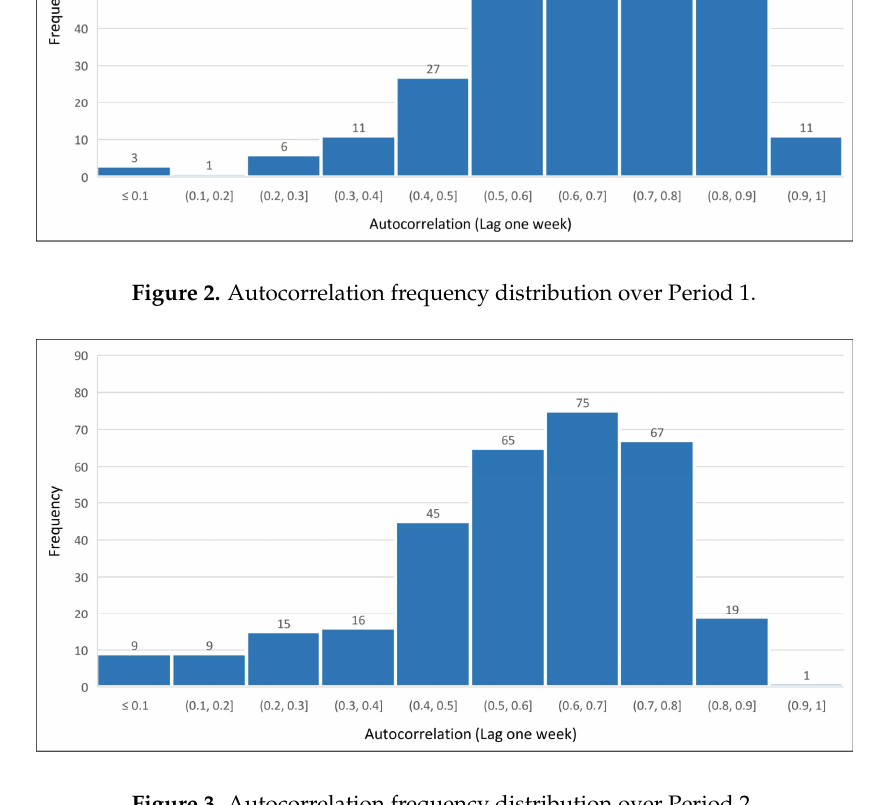
Figure 3. Autocorrelation frequency distribution over Period 2.